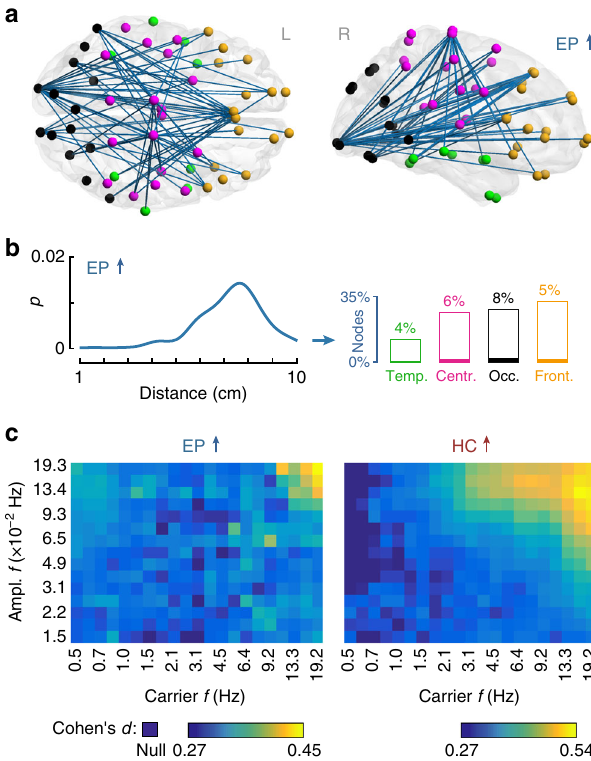
Fig. 3 Changes in cortico-cortical functional connectivity as a function of birth gestational age. a The main effect of group shows higher long-range connectivity in the alpha band in EP infants compared with HC. The corresponding widespread network is composed of temporal (green), central (pink), occipital (black), and frontal (orange) cortices ( p FWER < 0.0001, paired two-tailed t -test). b The line shows the distribution (kernel density estimate) of functional connections lengths, where p is the fraction of edges (normalized to the whole network). Bar plots show participation of broad cortical areas in each sleep-related network. c Spectral fi ngerprints of EP (left) and HC (right) infants. Colors show the effect size (Cohen ’ s d ) of group contrasts for all combinations of carrier vs . amplitude frequencies ( f ). Darkest blue shade marks the cases where there were posterior networks (comprising mostly occipital cortices) with visual performance. No signi fi cant associations between sleep- induced connectivity changes and visual behavior are detected for low-frequency bands. A negative correlation is also apparent for social-emotional performance, but the association is not statisti- cally signi fi cant when accounting for multiple comparisons (all p uncorrected > 0.039; Fig. 4b and Supplementary Fig. 2b). The